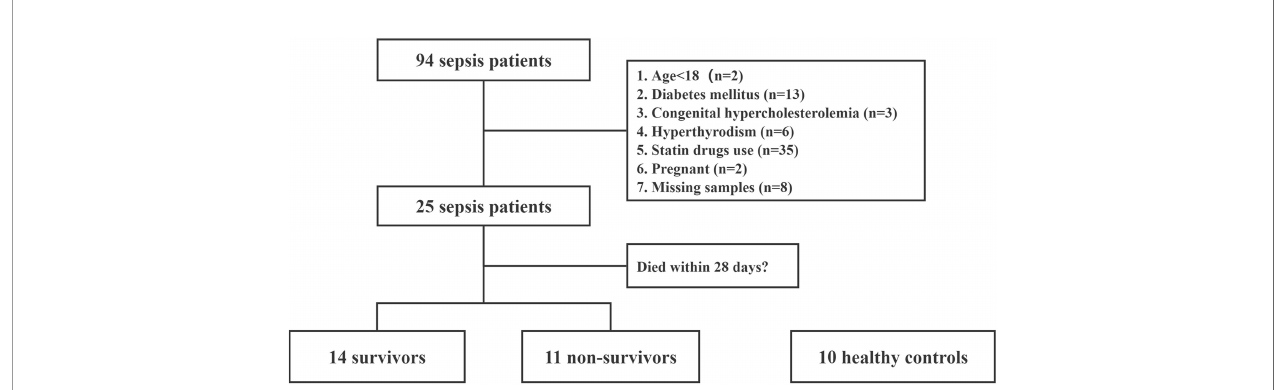
FIGURE 1 | Flowchart of patient enrollment. This is a study fl ow chart of septic patients along with healthy